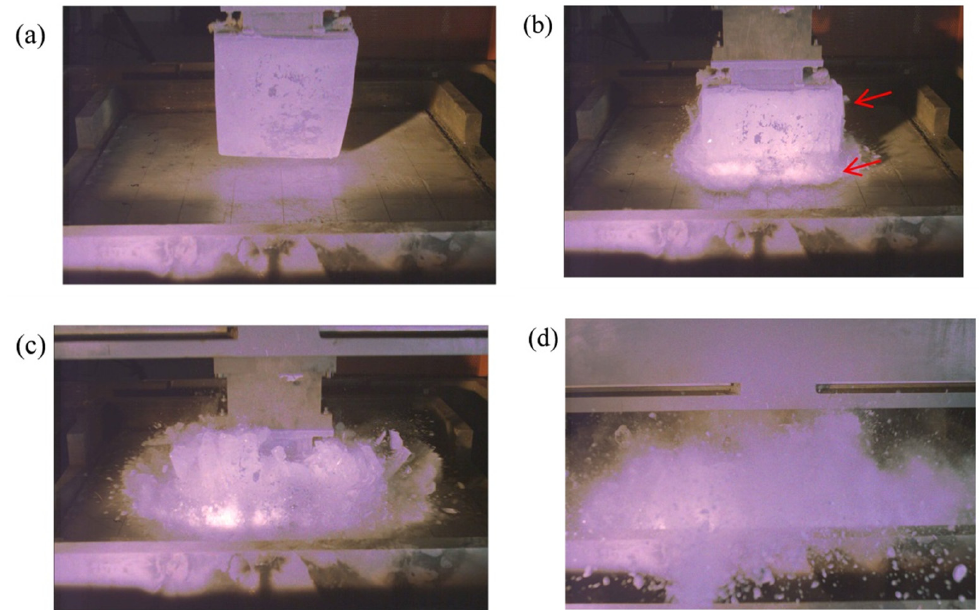
Figure 9. Sequence of images extracted from high-speed video recording showing impact process: ( a ) Initial contact; ( b ) Ice extrusion; ( c ) Ice partially broken; ( d ) Ice completely